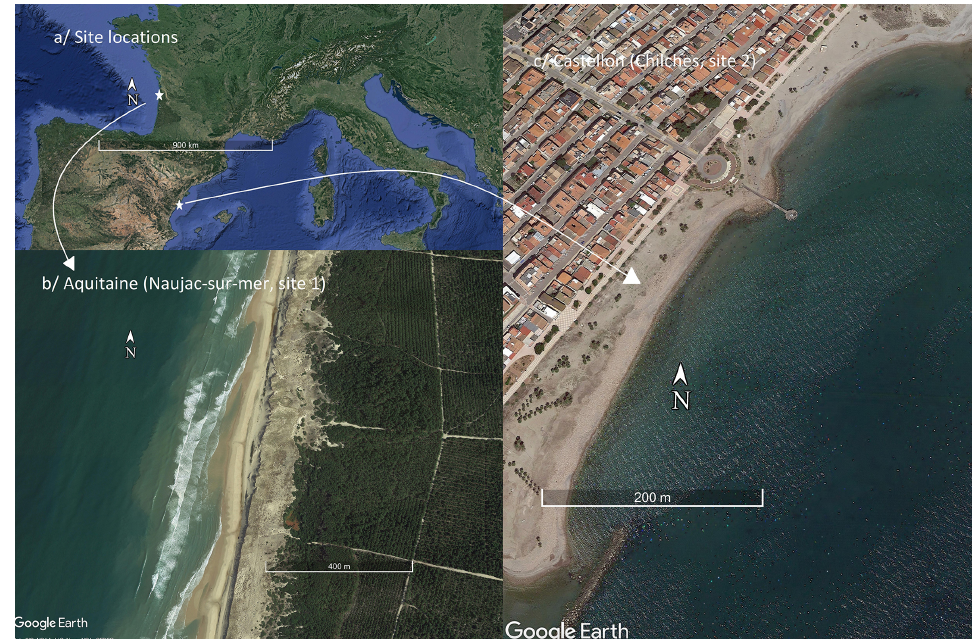
Figure 3. Location of the two case studies on the Aquitaine (site 1, b ) and Castellón (site 2, c ) coasts. Base maps are from Google